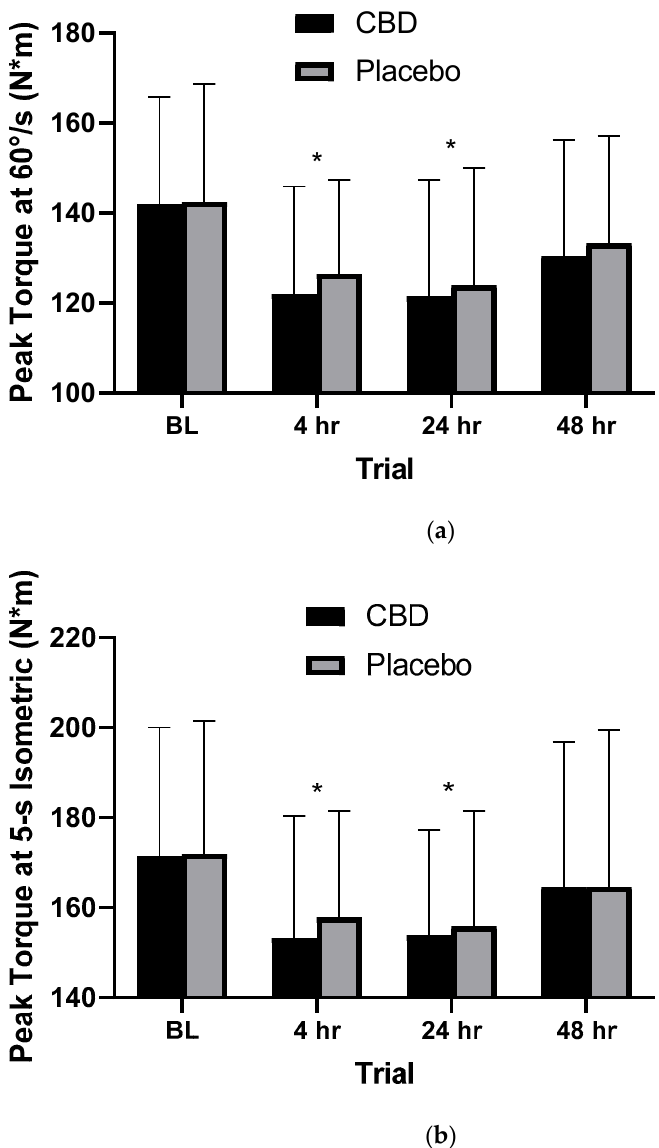
Figure 3. ( a ) Peak torque at 60°/s and ( b ) 5-s peak torque measures at various time points. * Statisti- cally significant difference ( p < 0.05) observed from baseline measurement. BL = 2 h prior to muscle damaging protocol, 4 hr = 4 h post-muscle damaging protocol, 24 hr = 24 h post-muscle damaging protocol, 48 hr = 48 h post-muscle damaging protocol. ( n = 24).